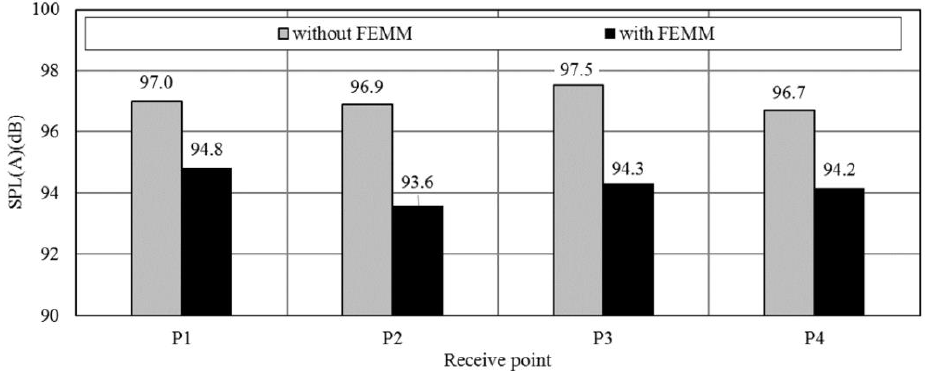
Figure 18. Comparison of the sound pressure level (SPL) at each microphone position. The RT decreased from 1.05–0.56 s at 500 Hz and decreased about 0.25–0.46 s at all frequencies, as shown in Figure 19.